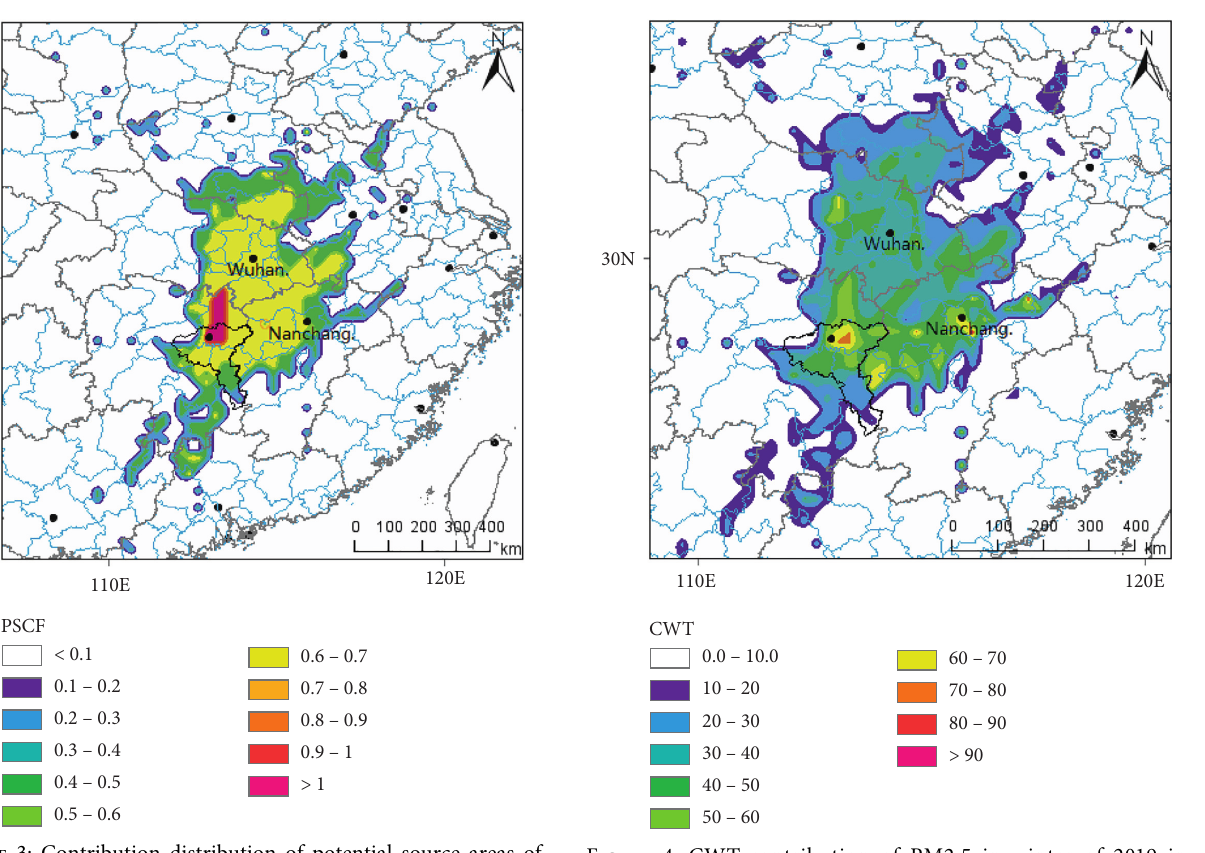
Figure 4: CWT contribution of PM2.5 in winter of 2019 in Chang-Zhu-Tan